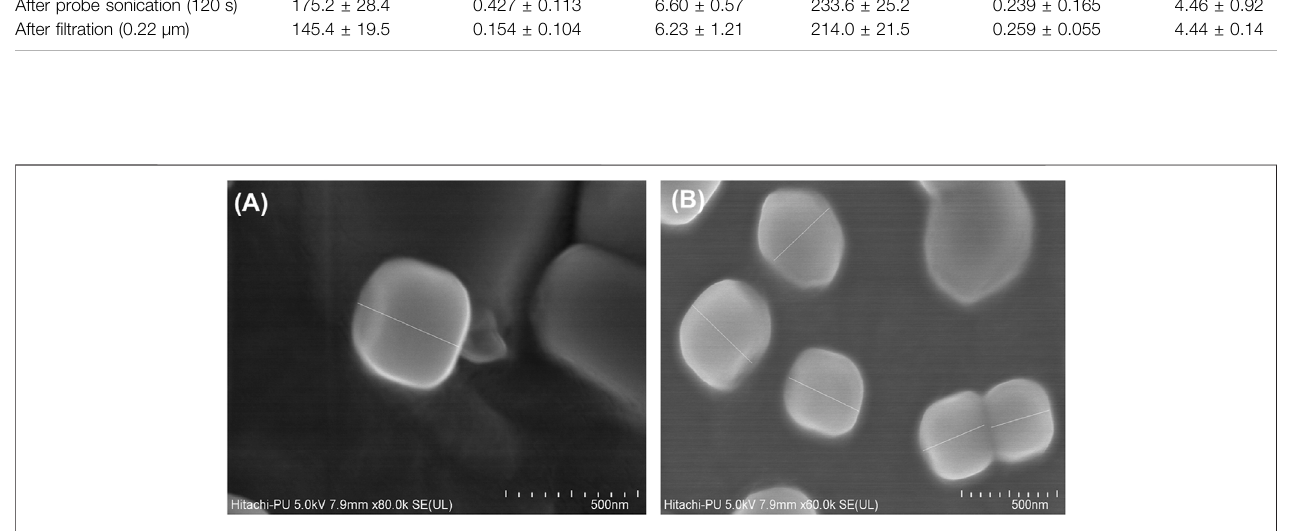
Frontiers in Pharmacology |